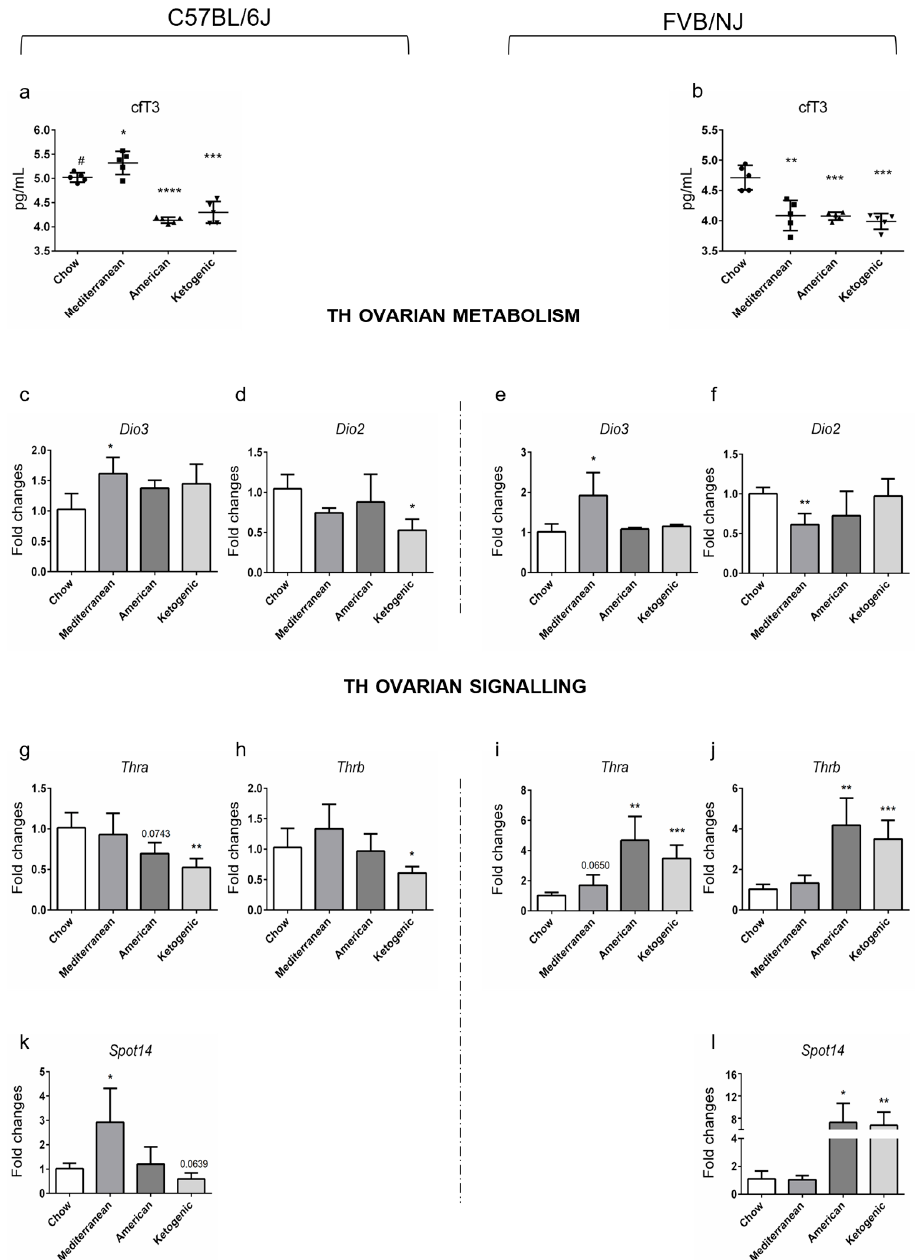
Figure 1. T3 levels changes in C57BL/6J and FVB/NJ mice fed different diets. ( a , b ) The dietary effects on circulating T3 (cfT3) levels were determined by ELISA assay ( n = 5/group). Significant differences are indicated with * p < 0.005; ** p < 0.01; *** p < 0.001, **** p < 0.0001 using Student’s t- test ( c – l ). The mRNAs implicated in THs metabolism ( Dio2 and Dio3 ) and signaling ( Thra , Thrb, and Spot14 ) were detected by RT-qPCR. Data are reported as the ratio between mRNA content in different diets and control groups normalized to β -actin. Data are mean ± s.d. with five animals per group. Significant differences are indicated with * p < 0.05; ** p < 0.01, and *** p < 0.001 using Student’s t -test. Student’s t- test for different relative to the cfT3 between C57BL6/J and FVB/NJ strain is indicated with # p < 0.05 .